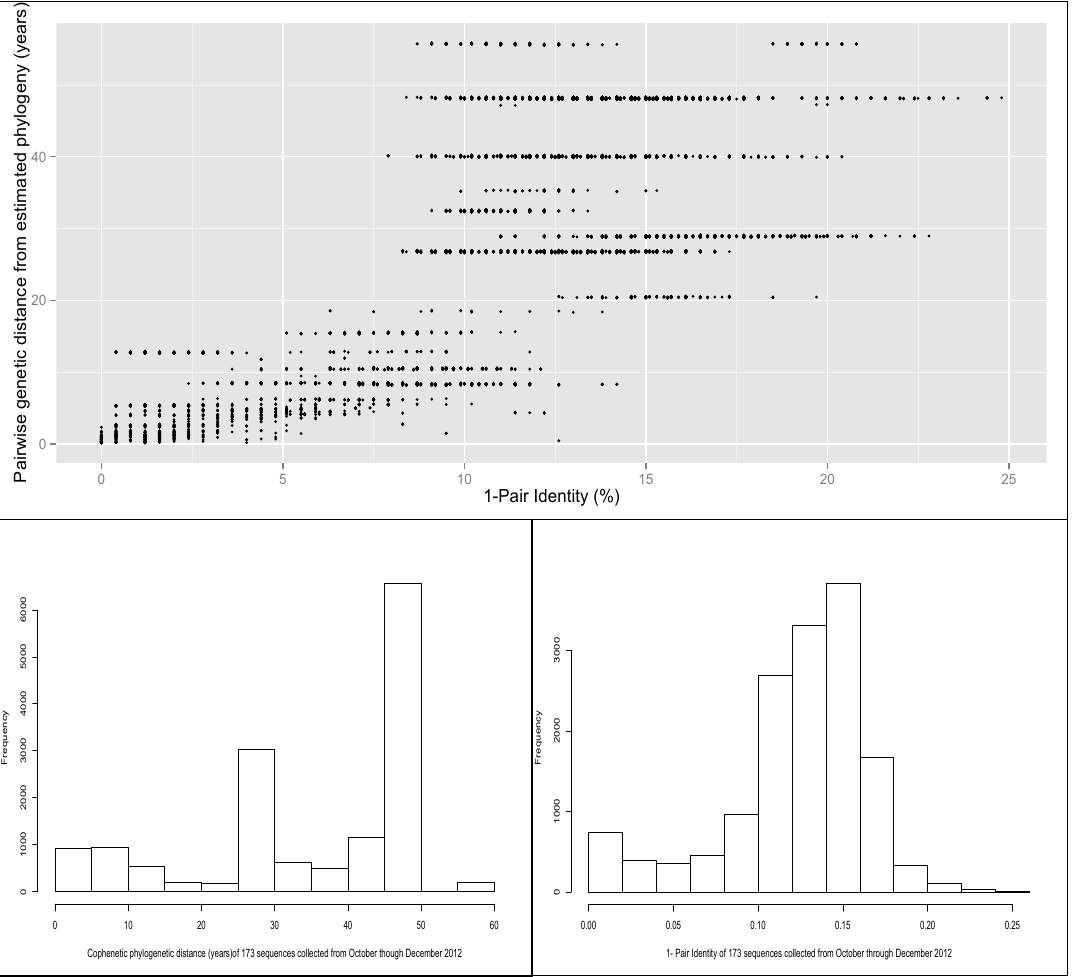
Figure 2. Maximum clade credibility tree. Sequences collected from air samples locations are indicated by color, location A (red), B (blue), C (green) and D (purple). The dotted line represents the cutoff to determine phylogenetic clades.